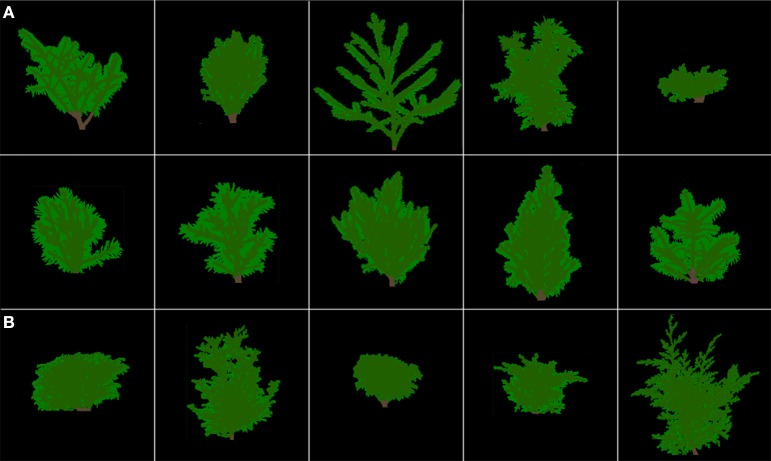
False-colored 3-D renderings of the complete crowns (branches in brown, leaves in green) for the 15 miniature conifers of Figure 4, in same order and size representation. (A) with needlelike leaves (first two rows) and (B) with scalelike leaves (third row).